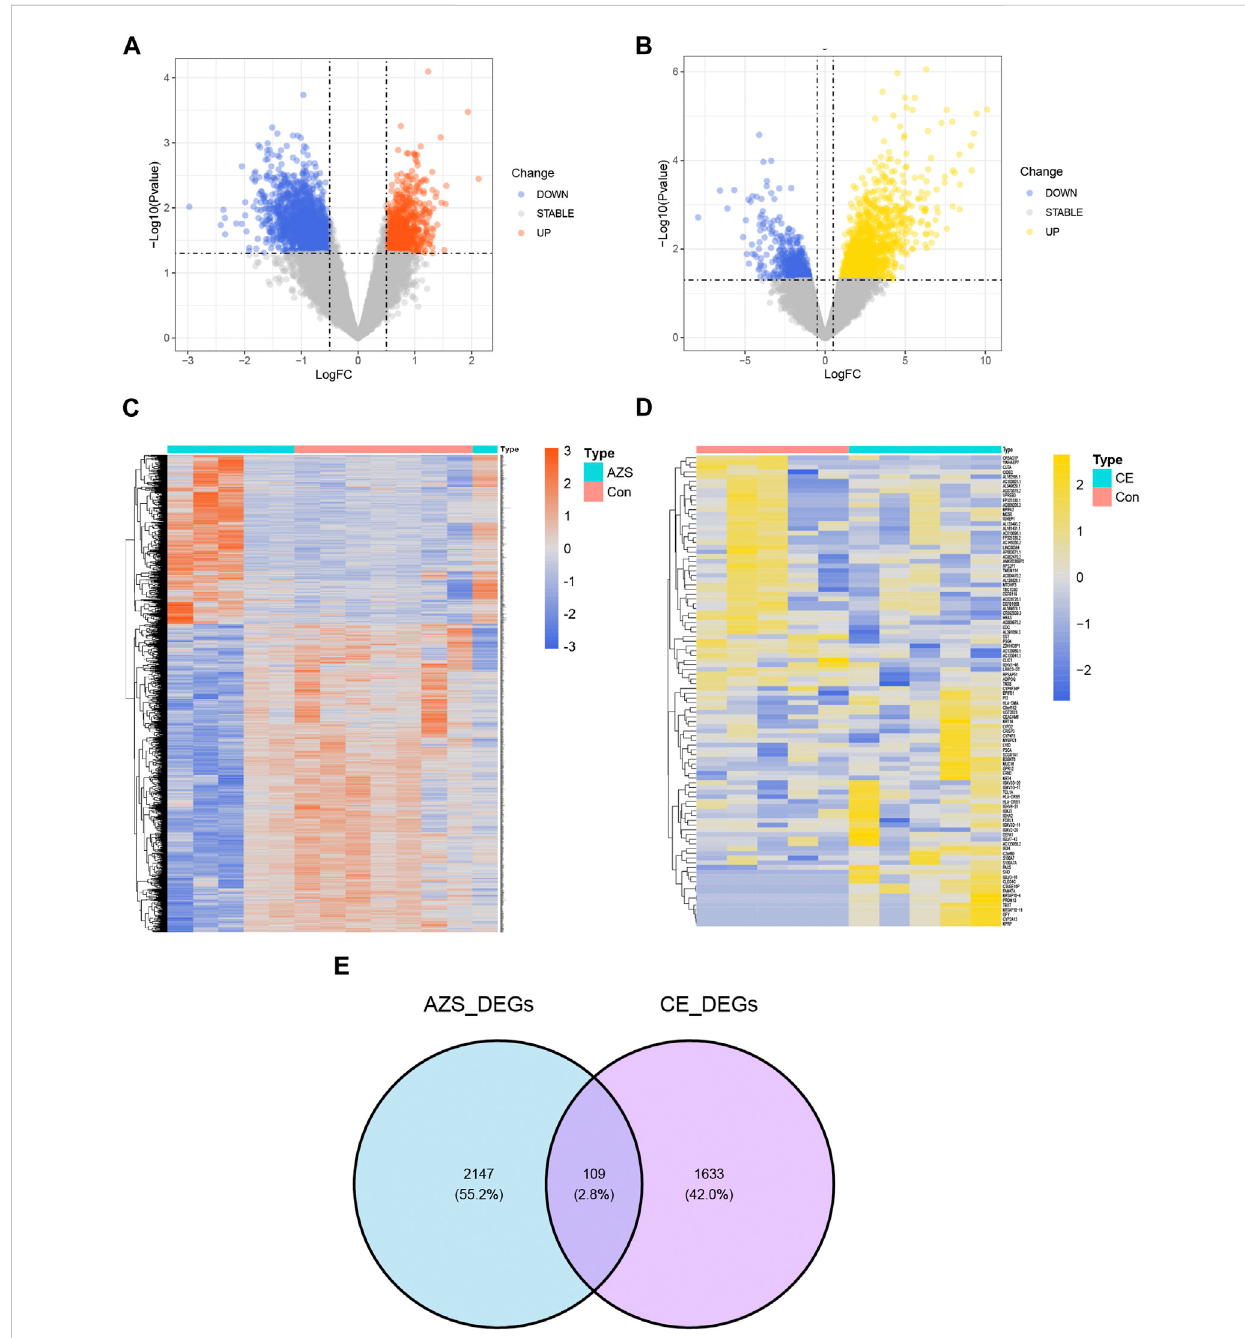
Differently expressedgenesintheintegrated AZSGEO dataset(GSE160749 andGSE22331)and theCEGEO dataset(GSE199903). (A) Inthevolcano map of DEGs in the integrated AZS GEO dataset, blue nodes denote downregulation, orange nodes denote upregulation, and grey nodes denote no signi fi cant difference. (B) Inthevolcano mapofDEGsintheCE GEOdataset, bluenodesdenotedownregulation,yellownodesdenoteupregulation, and grey nodes denote no signi fi cant difference. (C) The heatmap of DEGs in AZS. (D) The heatmap of DEGs in CE. (E) Venn diagram from intersected genes of the AZS DEGs and CE DEGs. AZS: asthenozoospermia; CE: chronic epididymitis; Con: Control; FC: fold change; DEGs: Differentially expressed